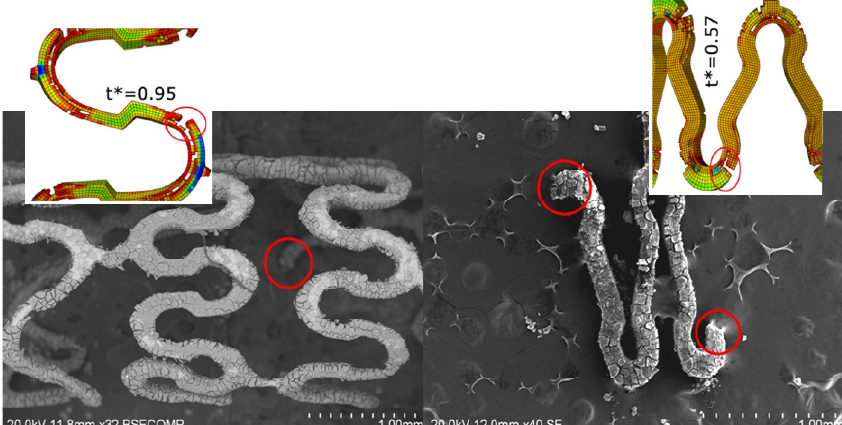
Figure 6: Experimental and numerical results of the corrosion tests of the optimized stent (left) and the patented stent